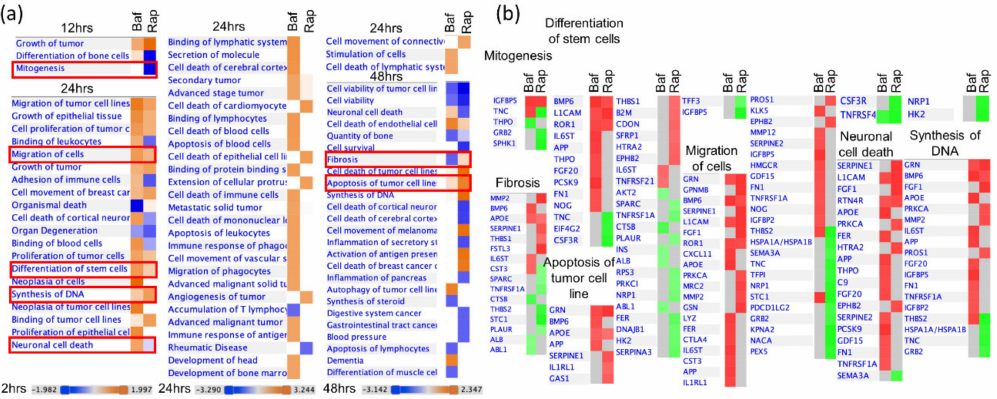
Figure 6. IPA-determined bio-functions altered by 2 nM BafA1 or 200 nM rapamycin. ( a ) Altered bio-functions with Z-Score > 1.96 (orange) or < − 1.96 (blue) at each time point. ( b ) Some of the bio-functions (outlined in red in a ) are shown in greater detail, with dysregulation of specific proteins indicated (red blocks indicate up-regulated; green indicates down-regulated).